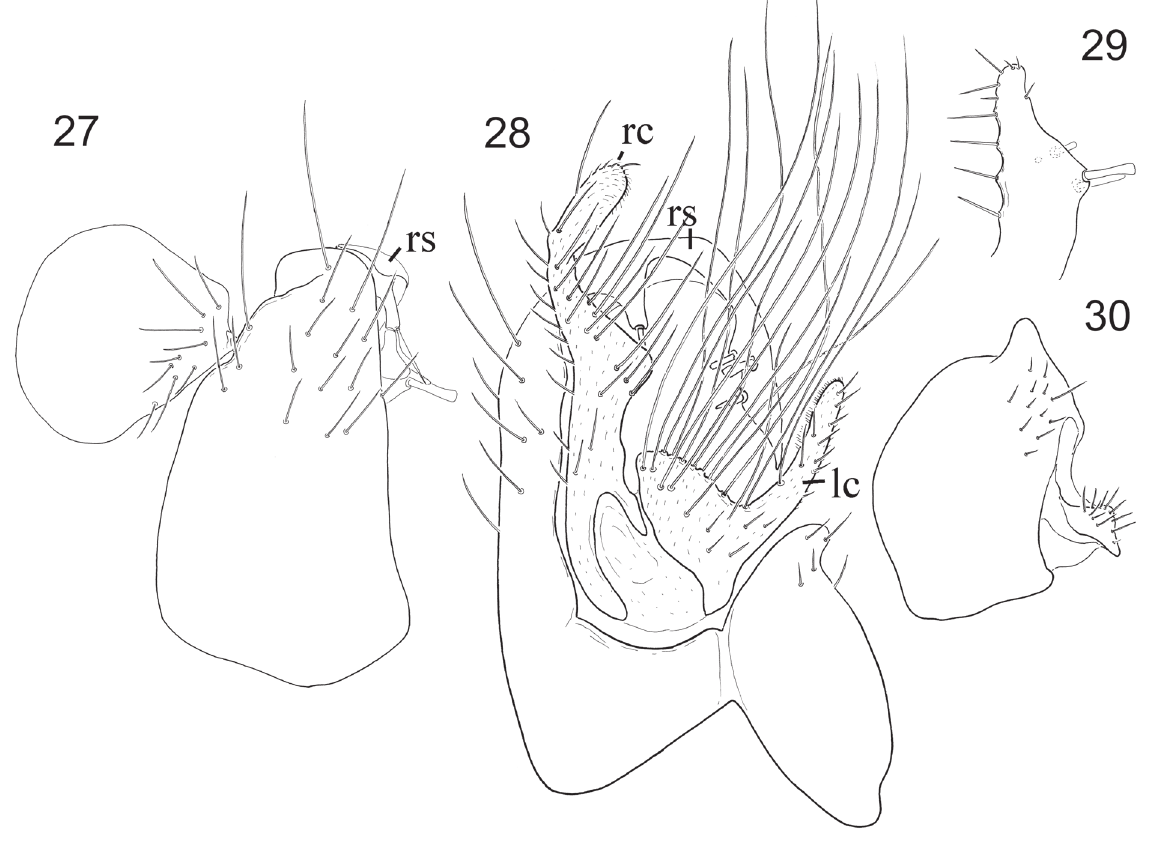
Figs 27-30. Tachydromia luang Shamshev & Grootaert, 2005, ♂ terminalia. 27 . right epandrial lamella, lateral view. 28 . epandrium with cerci, dorsal view. 29 . left surstylus, lateral view. 30 . detail of tip right surstylus, dorsal view (after Shamshev & Grootaert